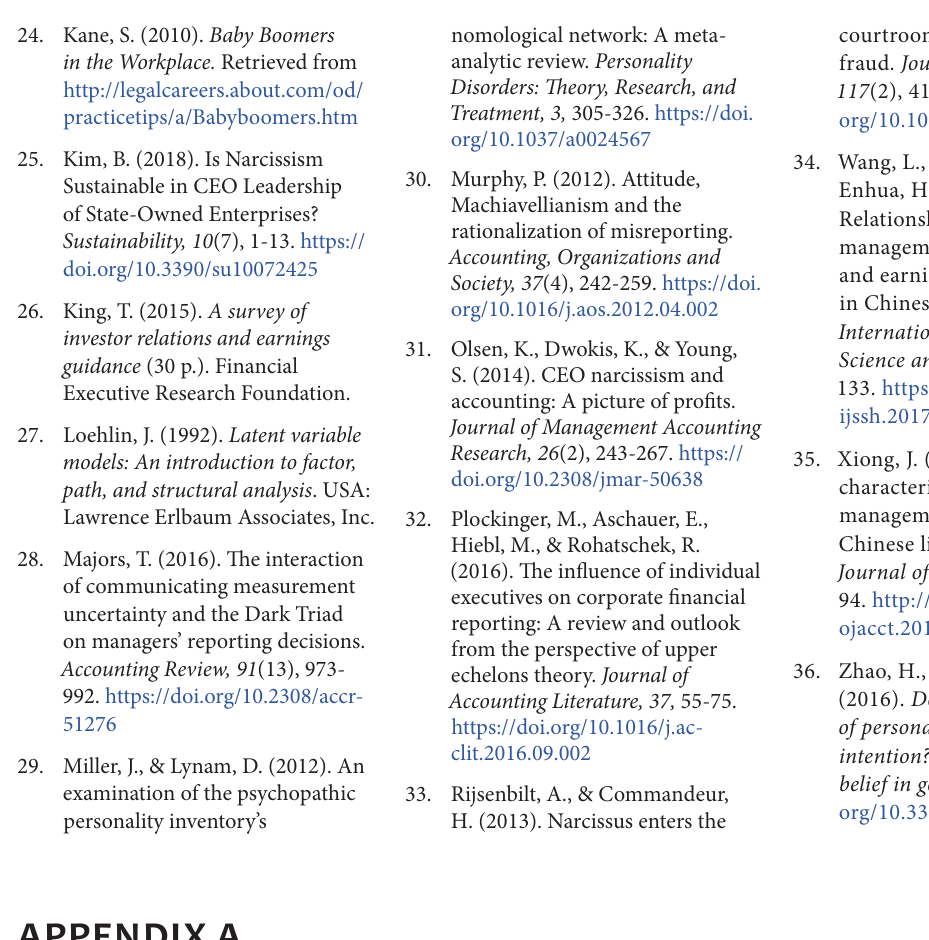
Table A1. Confirmatory factor analysis (upper echelons’ personality traits)